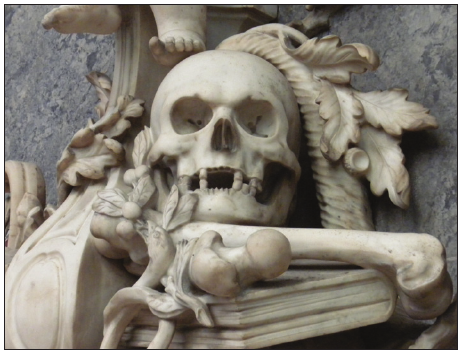
Figure 5: Detail from a memorial in St Mary’s Church, Walthamstow, Essex. Showing exact anatomical detail of the skull and both femurs (Photo